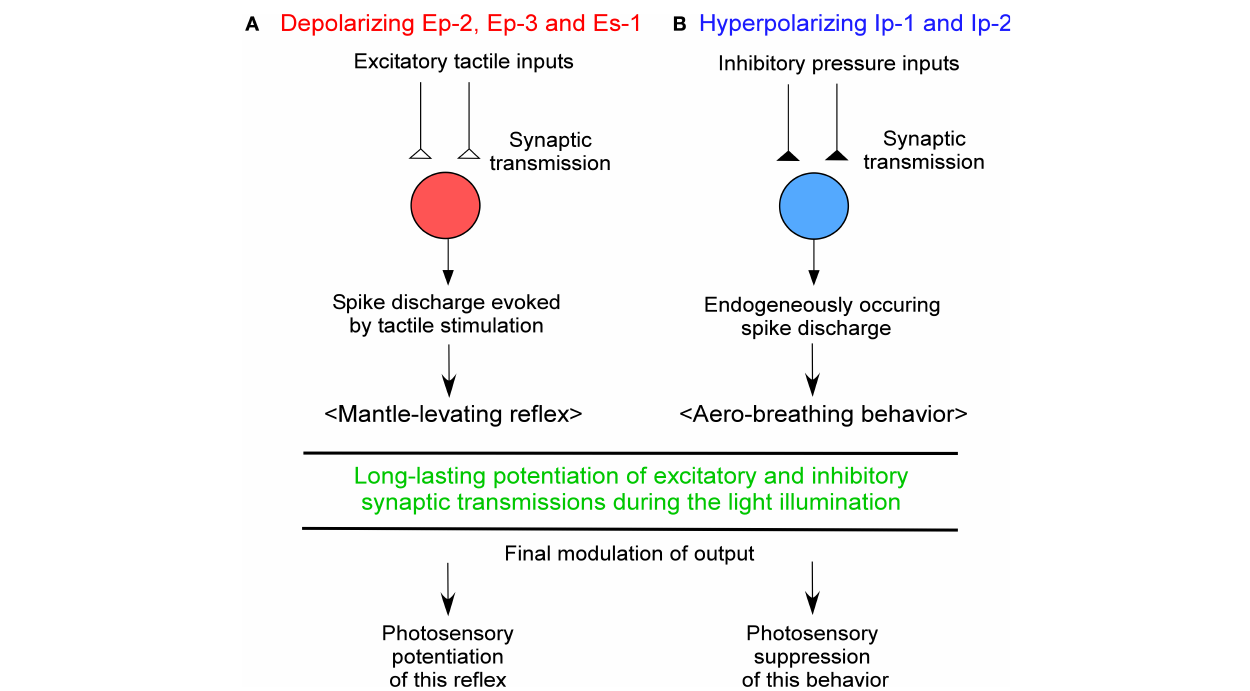
FIGURE 1 | Chart showing a new photosensory function of Onchidium simple photoreceptors, (A) depolarizing and (B) hyperpolarizing cells. See text for